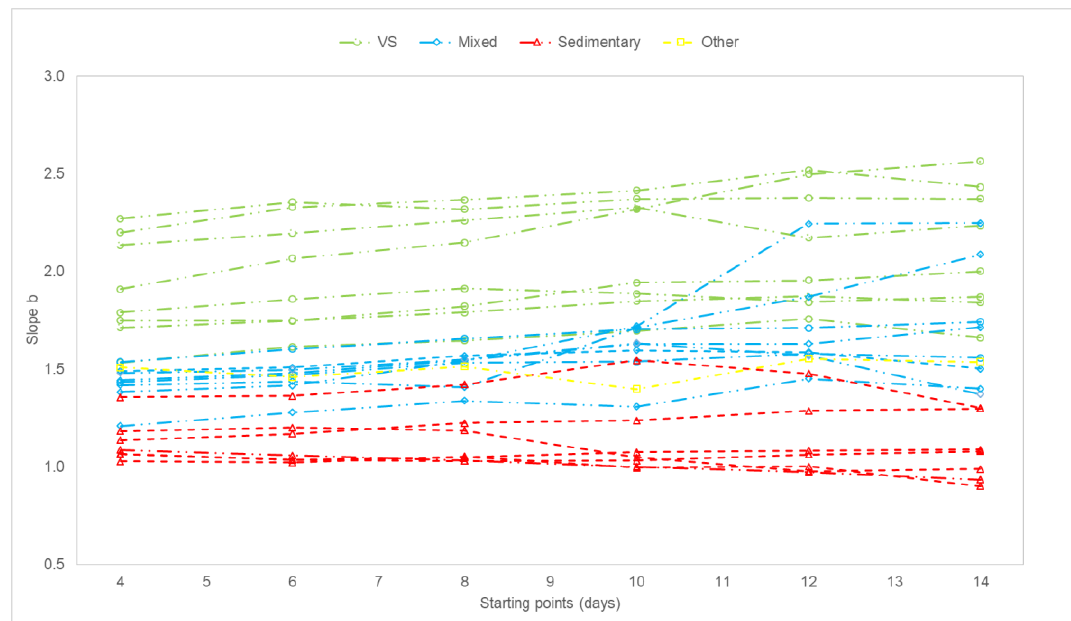
Figure 8. Variability in slope b due to the change in the recession starting point. Green circles are watersheds with a predominance of volcanic sequences, blue diamonds are watersheds with mixed geology, red triangles are sedimentary watersheds, and yellow squares indicate a basin with intrusive and metamorphic geological influence.